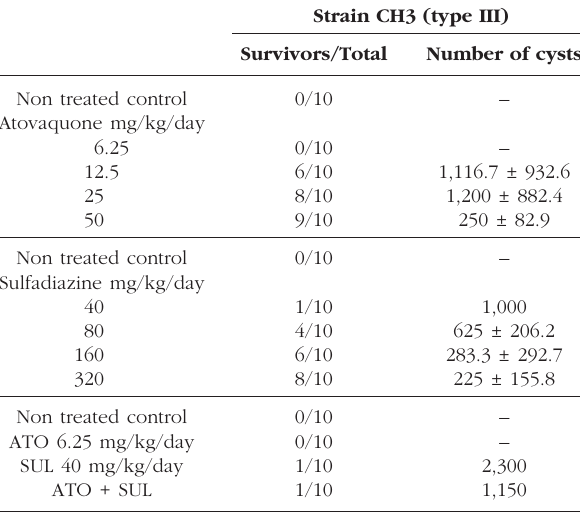
Table VI. – Survival and number of brain cysts in mice infected with CH3 strain of T. gondii and treated with different doses of atova- quone (ATO), sulfadiazine (SUL) or drug association (ATO +